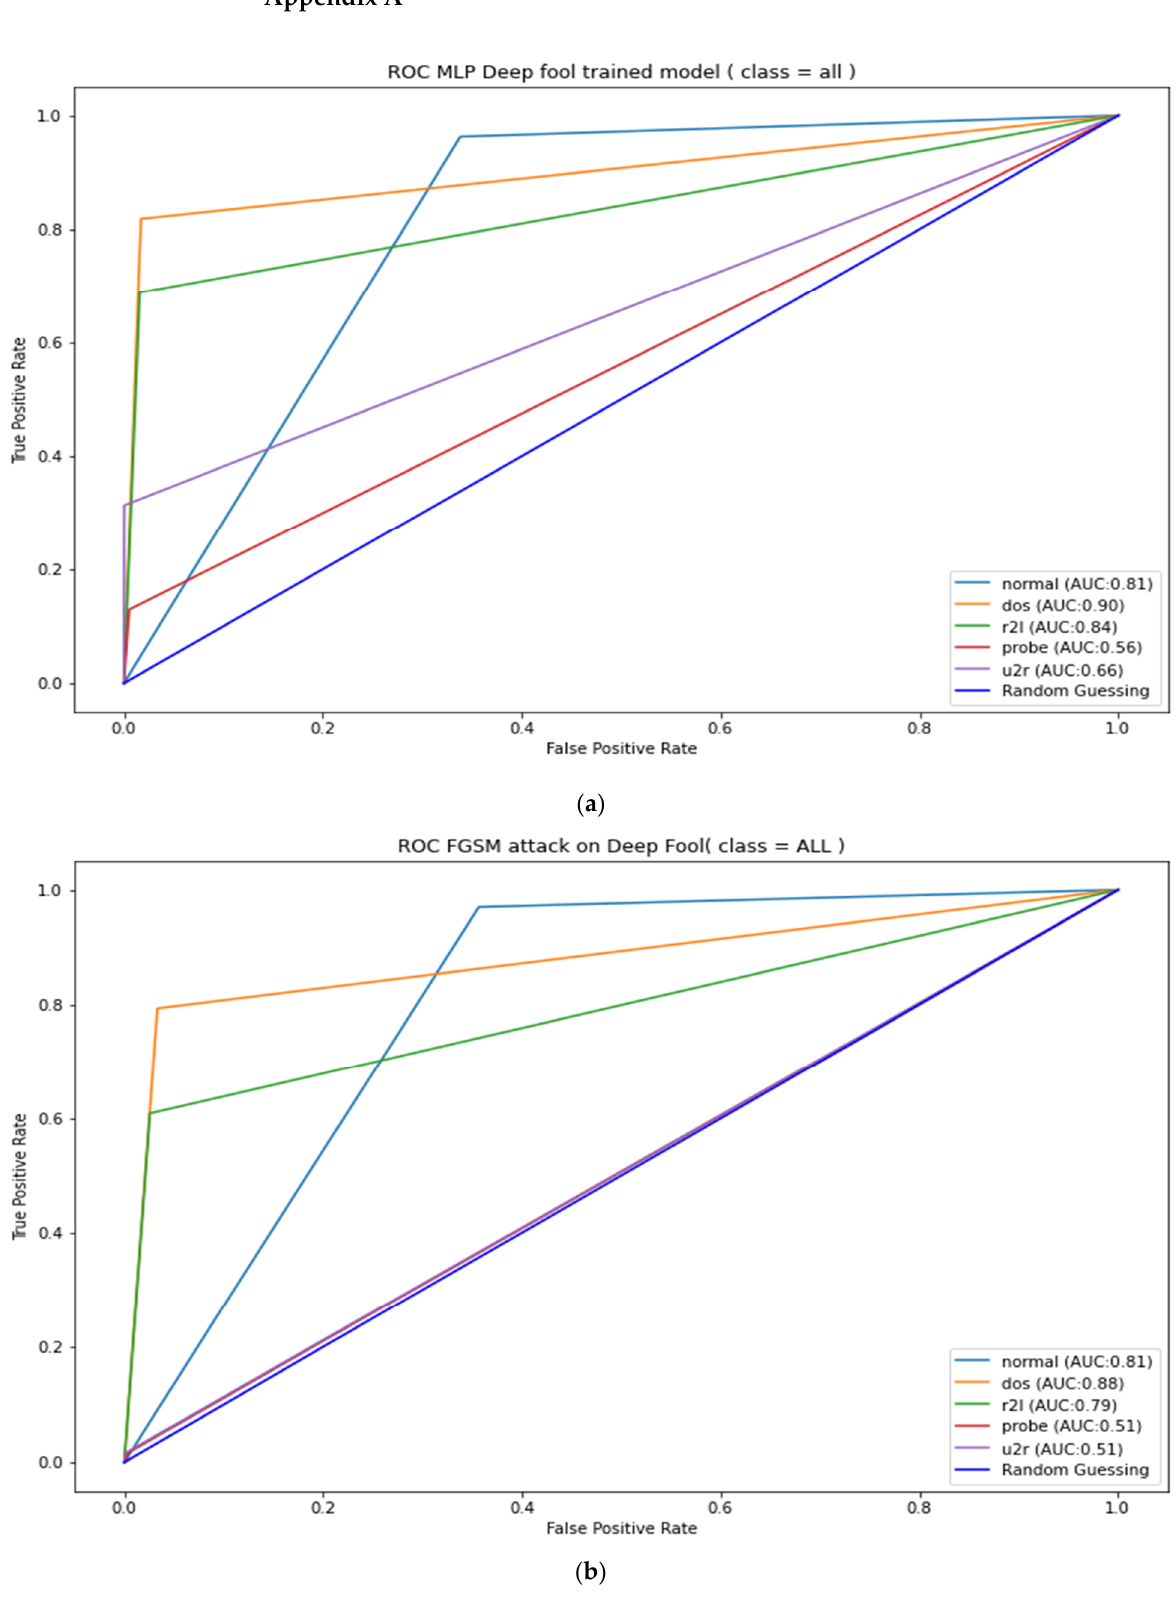
Figure A1. DeepFool adversarial-trained model ROC-AUC ( a ). DeepFool robustness test against FGSM ( b ).